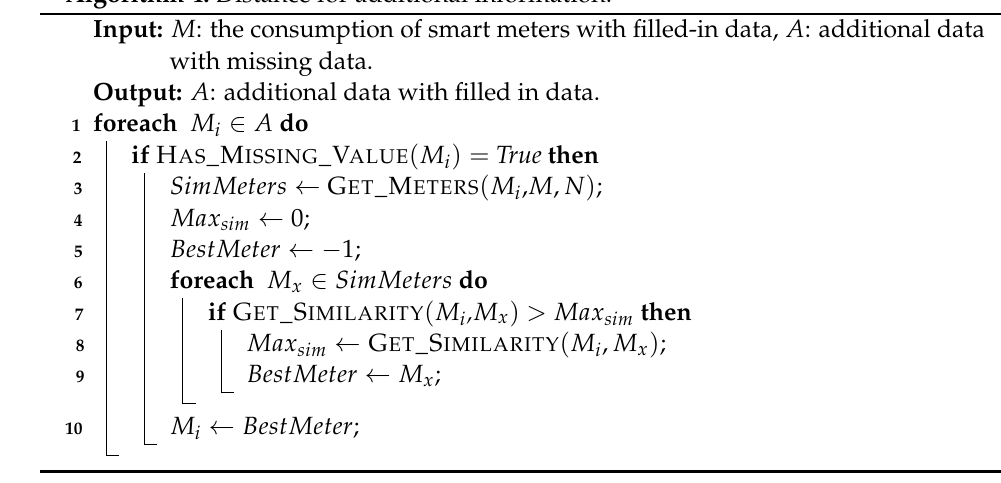
Algorithm 4: Distance for additional information.